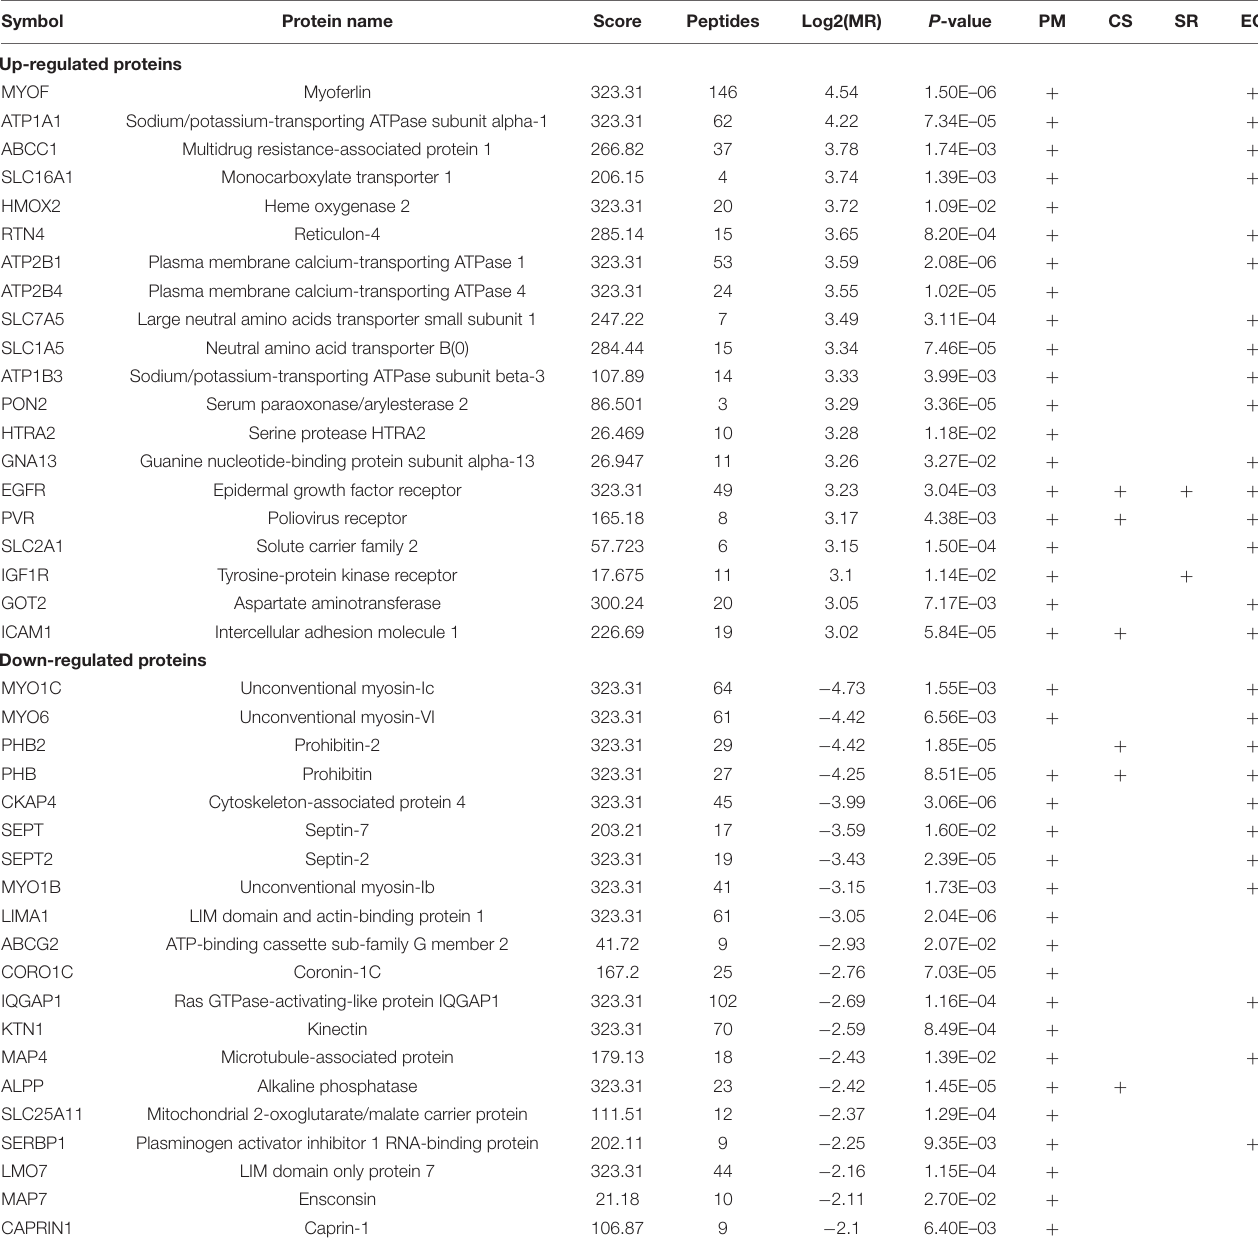
TABLE 2 | Top 20 list of up- and downregulated proteins in 5-8F vs. 6-10B cells. Symbol Protein